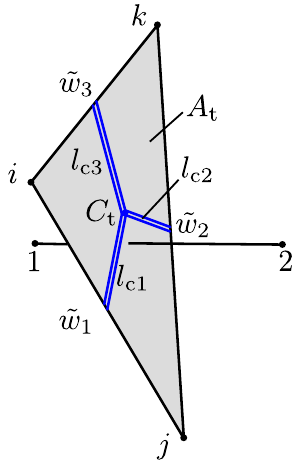
Figure 4. Influence of cracking on